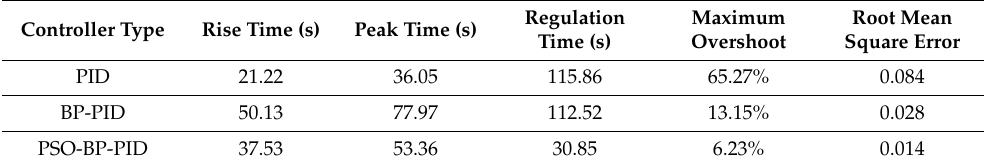
Table 3. Comparison of the dynamic performance of three controllers at fertilizer application flow rate of 0.6 m 3 /h.